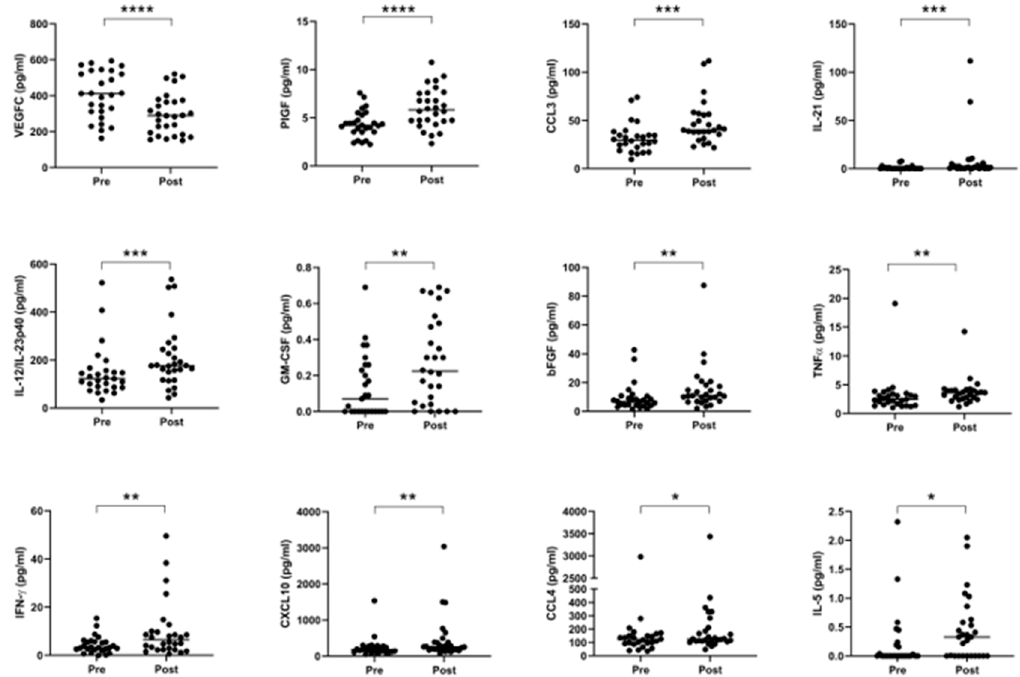
Figure 5. Serum pro-inflammatory cytokines are increased, and anti-angiogenic cytokines are decreased following neo-adjuvant treatment. Cytokines were measured before and after treatment in a cohort of 28 matched donors. Levels of VEGFC were lower after treatment, but other proteins were elevated, specifically PlGF, CCL3, IL-21, IL-12 / IL-23p40, GM-CSF, bFGF, TNF- α , IFN- γ , CXCL10, CCL4, and IL-5. Pre- and post-treatment datasets were compared using a Wilcoxon matched pairs signed rank test, * p < 0.05, ** p < 0.01, *** p < 0.001, **** p < 0.0001. VEGF = Vascular Endothelial Growth Factor, PlGF = Placental Growth Factor, IL = Interleukin, GM-CSF = Granulocyte-Macrophage Colony-Stimulating Factor, bFGF = Basic Fibroblast Growth Factor, TNF = Tumor Necrosis Factor, IFN = Interferon.